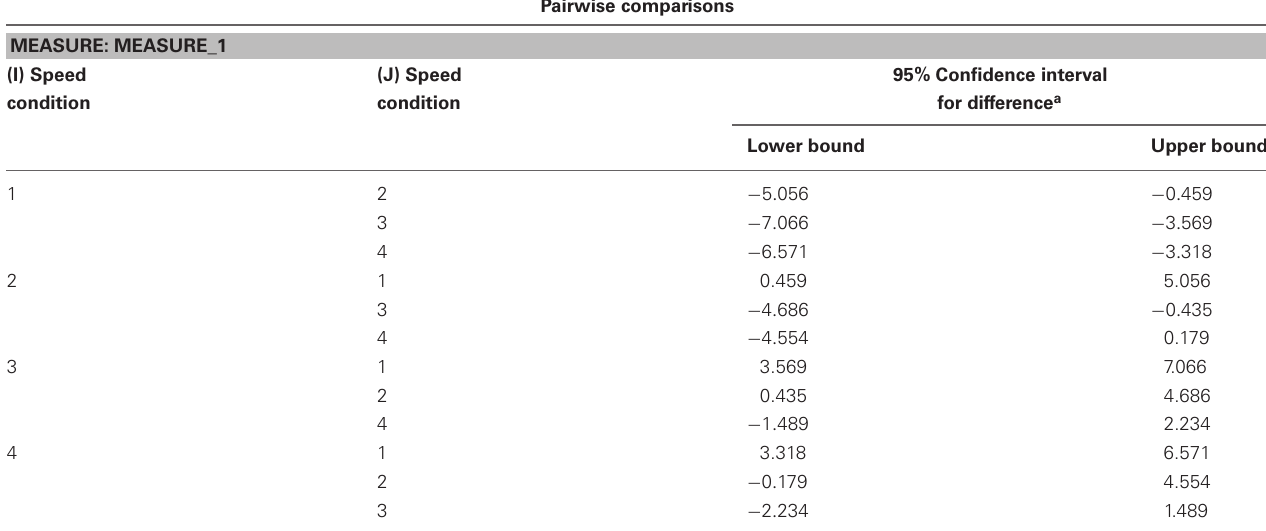
Table A3 | The straight driving speed and lane position measures were not significantly different from those during the distracted straight driving